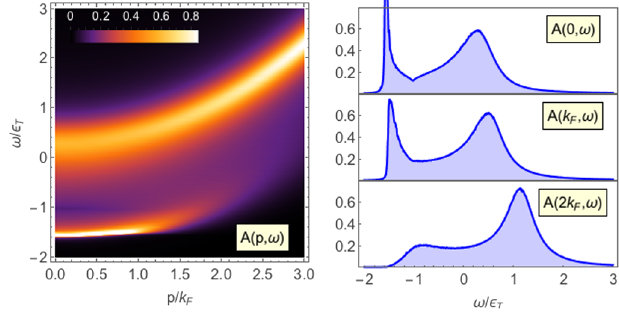
FIG. 4. Self-consistent spectral function of excitons at zero exciton density, μ ening 1 = 2 τ